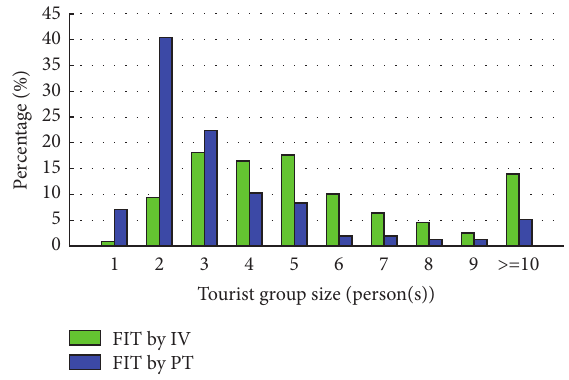
Figure 1: Distribution of tourist group size.